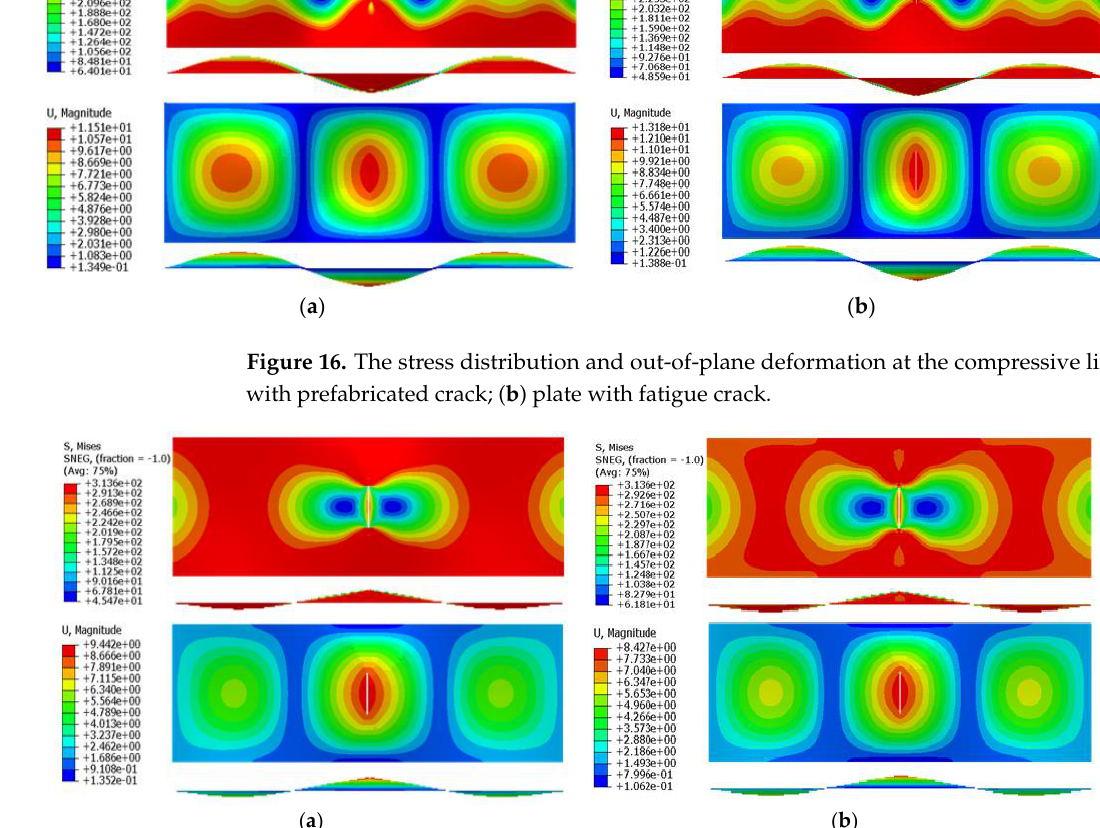
Figure 17. The stress distribution and out-of-plane deformation at the tensile limit: ( a ) plate with prefabricated crack; ( b ) plate with fatigue crack.